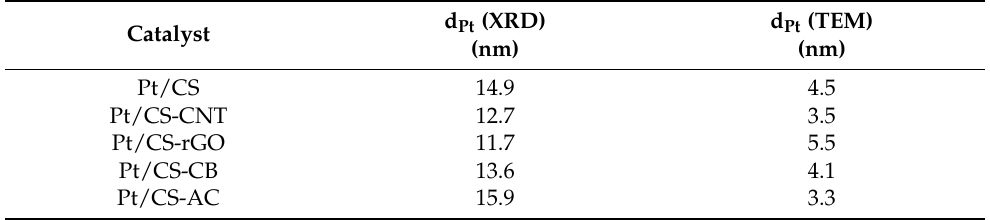
Table 2. Pt-particle size (d Pt ) estimated by X-ray powder diffraction (XRD) and transmission electron microscopy (TEM)